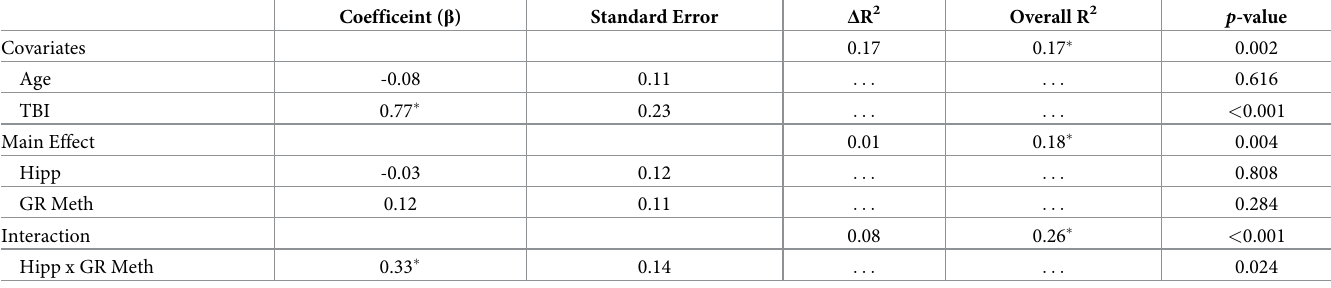
Table 2. Hierarchical regression model results. Standard coefficients are reported.